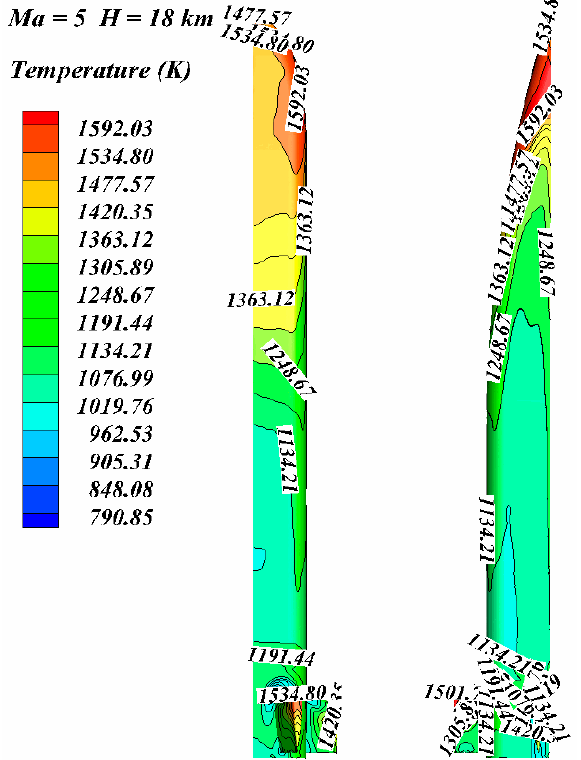
Figure 6. Isothermal distribution of leeward side at Ma 5.